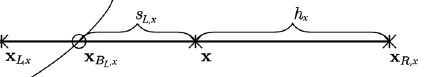
FIG. 2. Representative example of a boundary left of x in x − h x − s x -direction. x · ˆ e , x · ˆ e , x and x L;x ¼ x x B;x ¼ L;x x R;x ¼ x þ h · ˆ e are the point outside of Ω , boundary point, near- x x boundary point, and interior point, respectively. Similar for the y and z